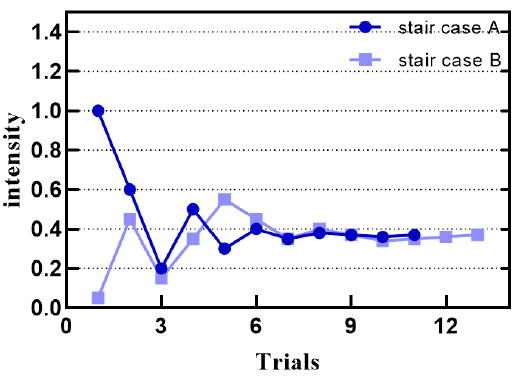
Figure 8. The result of the absolute threshold measurement. An example: absolute threshold measurement result of two staircase programs.